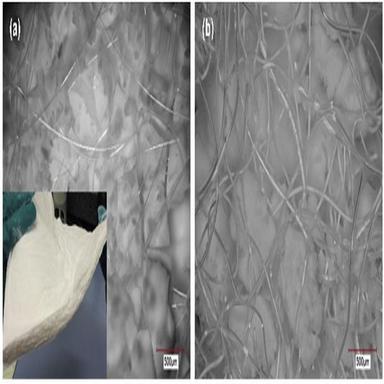
Digital microscope image of (a) QTZ/ARG and (b) CDC/ARG. Picture of QTZ/ARG sample on bottom corner on (a).